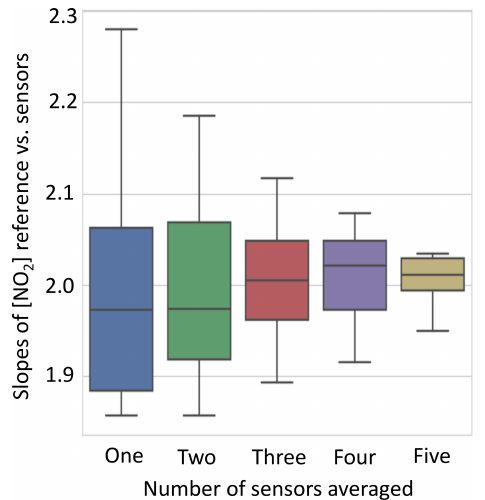
Figure 3. Comparison of slopes of concentrations derived from clusters of NO 2 EC sensors against a reference instrument for ambi- ent Beijing air. As the number of sensors used increases, the spread in data narrows, as seen through the difference in slope. If data from three out of six sensors are used there are 20 possible permutations of sensors. The average signal of each was calculated, then plotted against the reference NO 2 CAPS measurements, and the gradient was extracted. The 20 gradients of these correlation plots (sensi- tivities) are then plotted in the box plots above, with the median, 25th percentile, and 75th percentile in the box and the 5th and 95th percentile on the